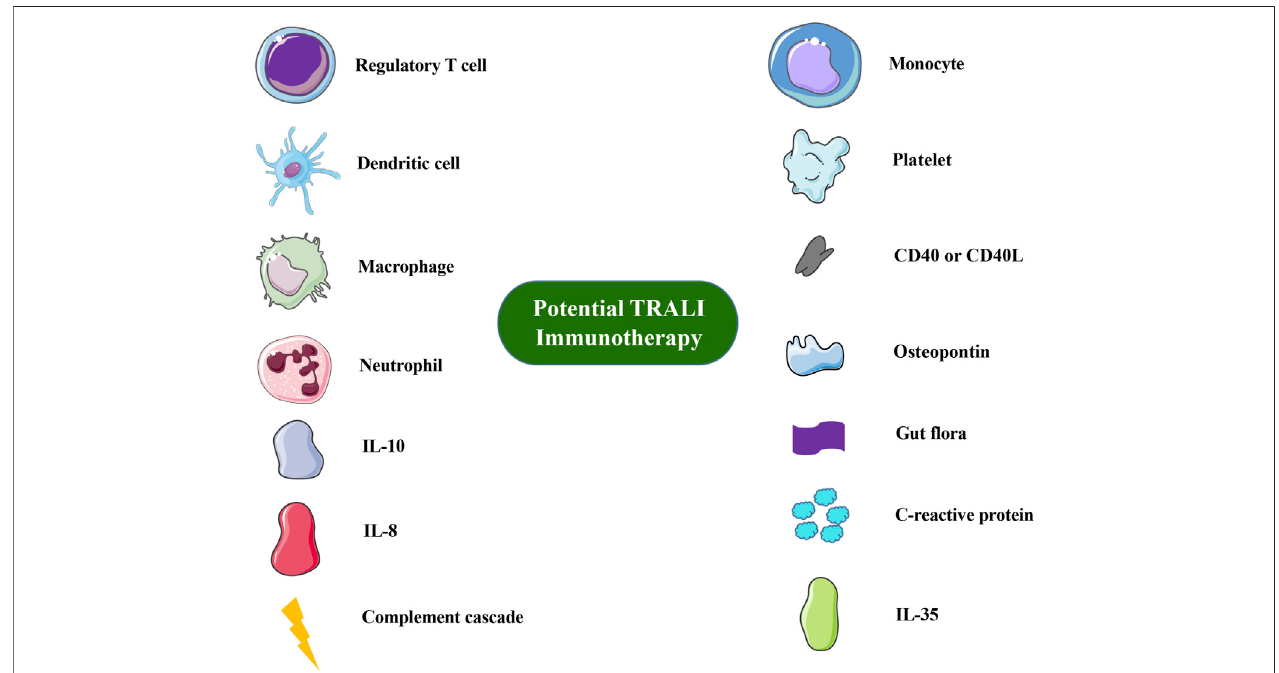
FIGURE 1 | Overview of immune cells or molecules involved in TRALI immunotherapy or prevention. Images of cells and molecules were in part produced or modi fi ed using the Smart Servier Medical Art (https://smart.servier.com/), which is licensed under a Creative Commons Attribution 3.0 Unported License (https:// creativecommons.org/licenses/by/3.0/).